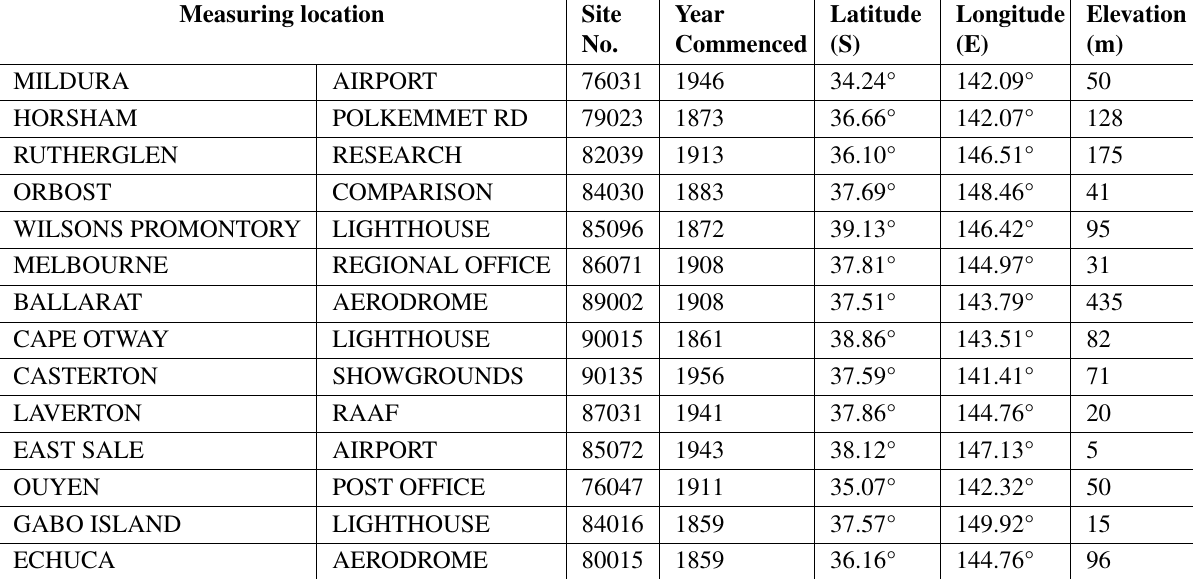
Table 1. List of stations